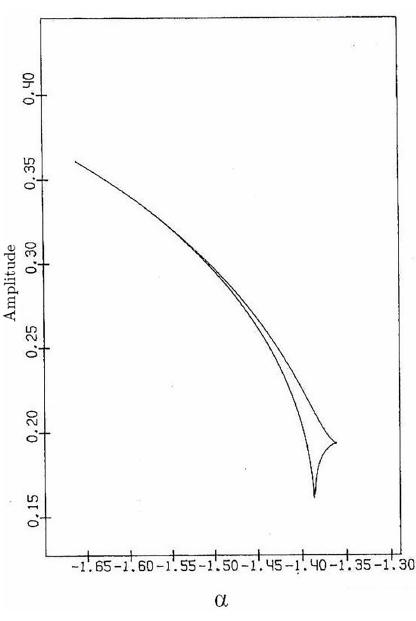
Figure 1. Existence domain for the two-humped solitary wave.